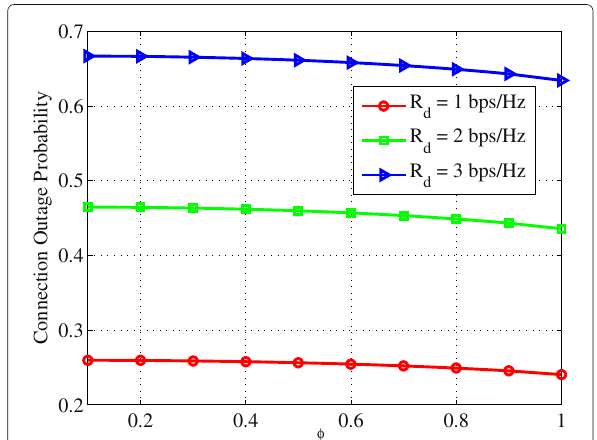
Fig. 9 The connection outage probability of the typical D2D link versus power allocation ratio φ . Figure 9 depicts the relationship between the connection outage probability of the typical D2D link and the power allocation ratio